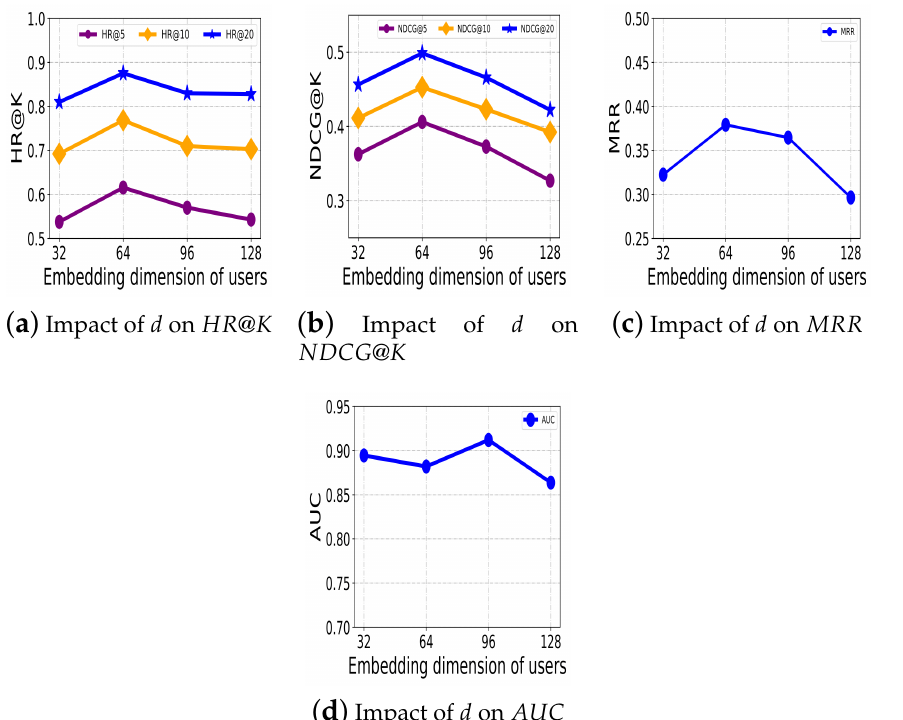
Figure 8. Parameter sensitivity of AGMKRec over embedding dimension d .